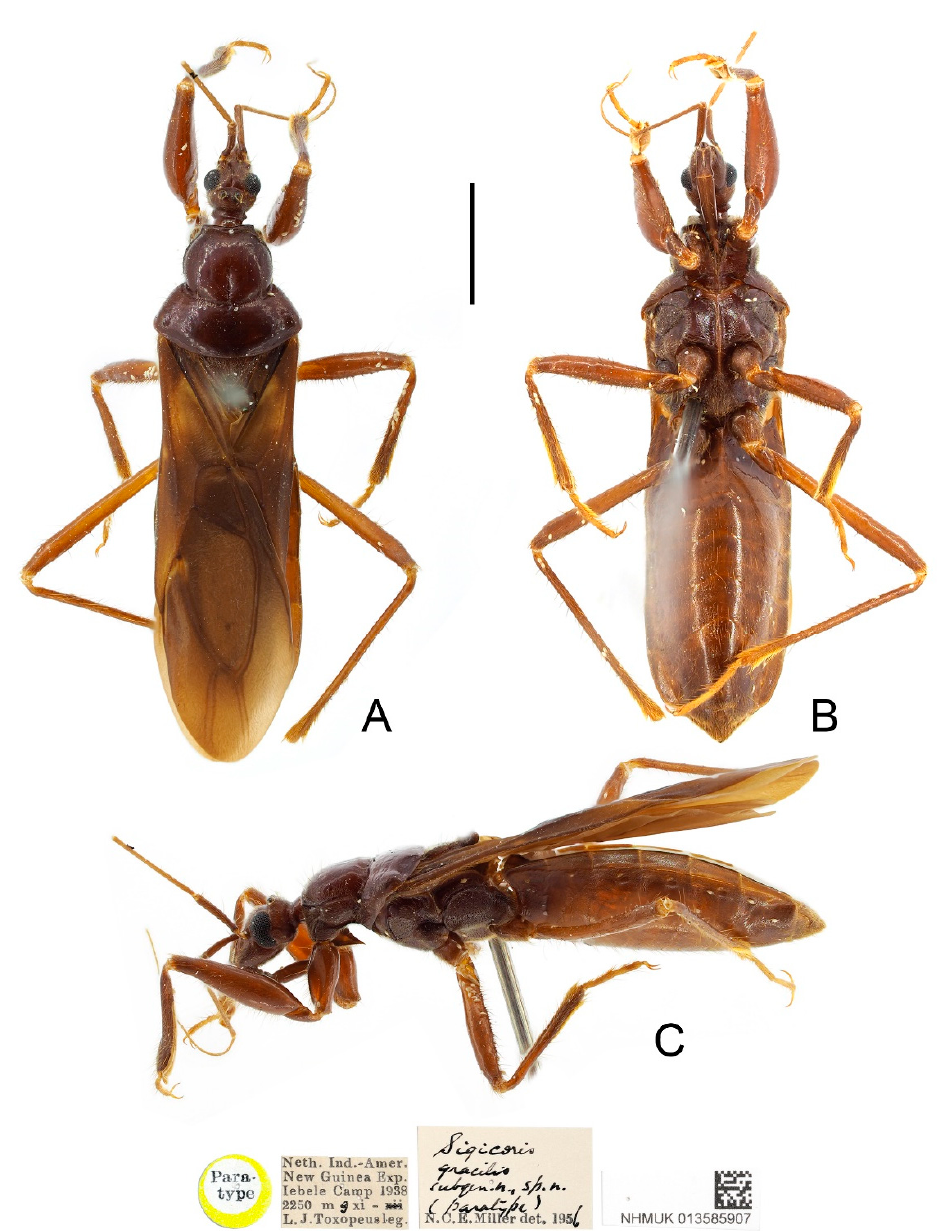
Figure 11. Sigicoris gracilis comb. nov. , paratype female, habitus. ( A ) Dorsal view. ( B ) Ventral view. ( C ) Lateral view. Scale bar = 3.00 mm.